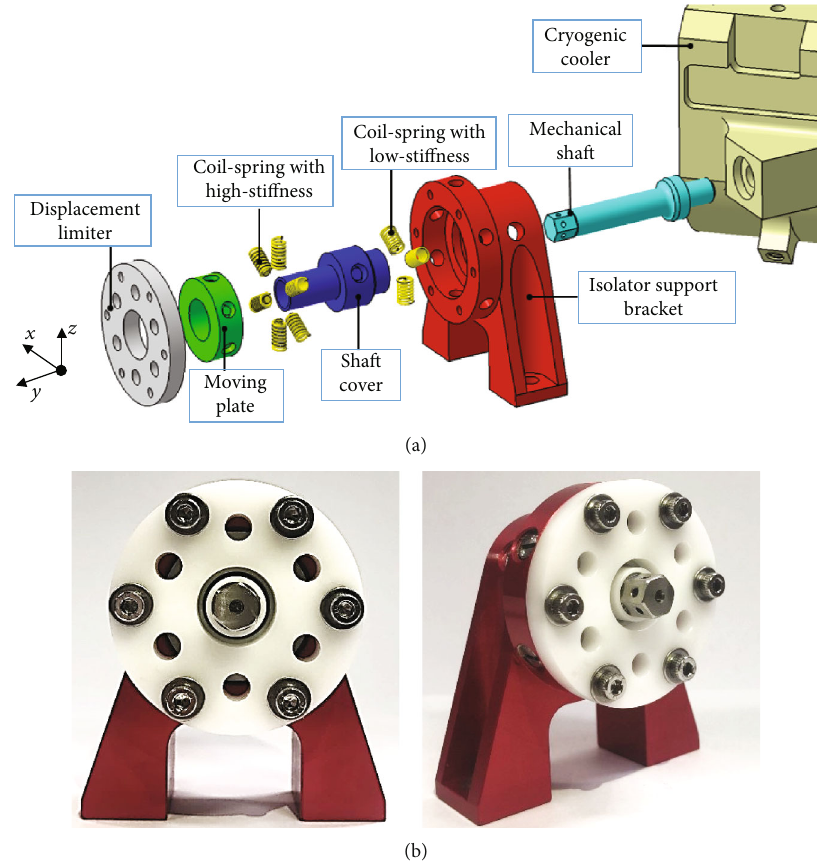
Figure 2: Con fi guration of the PLOVIS-II ((a) exploded view, (b) front and isometric